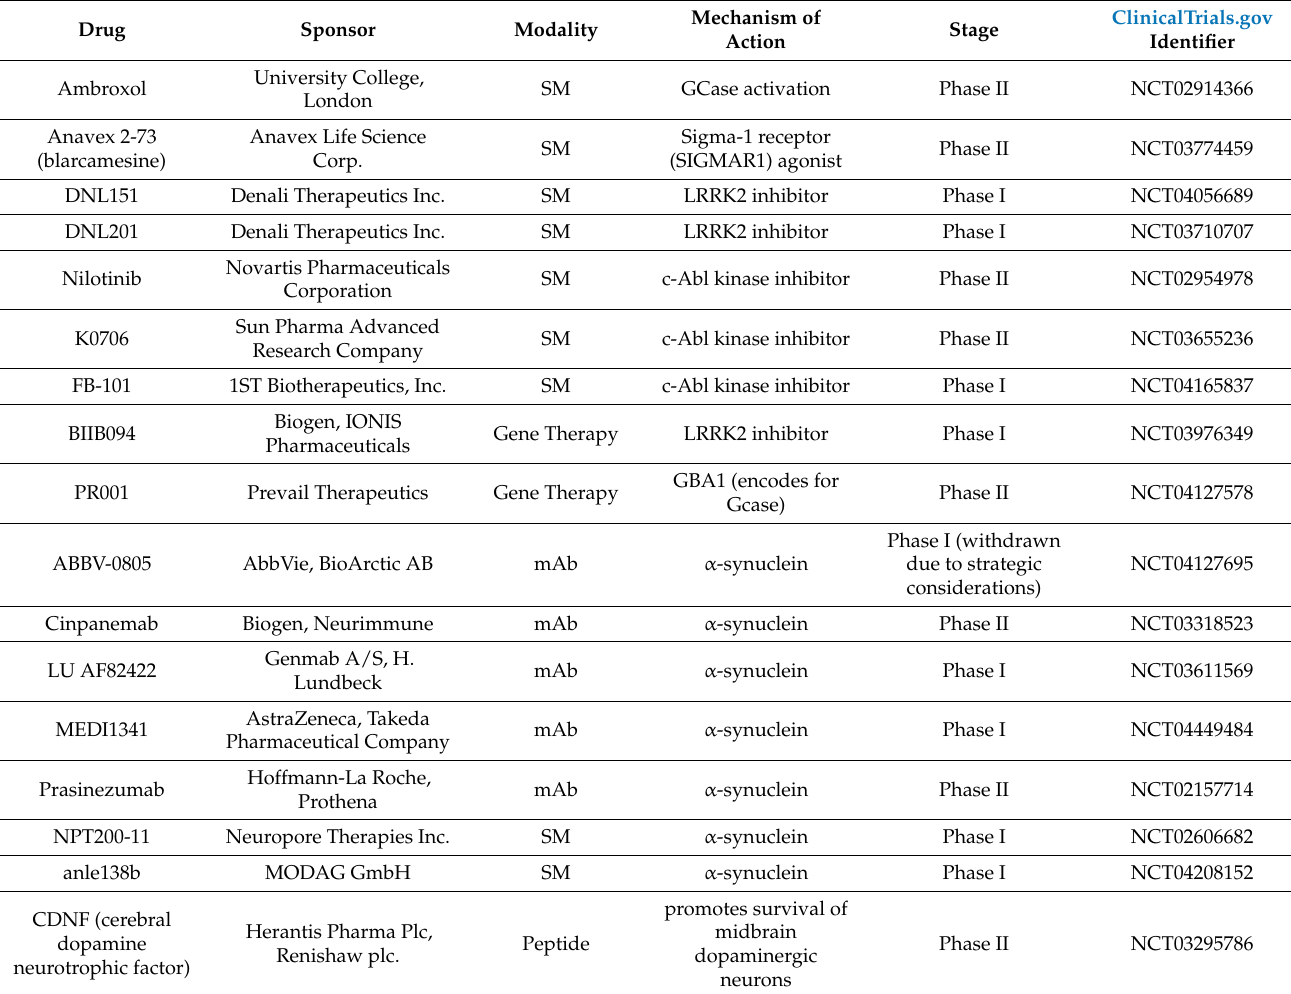
Table 15. Status of select PD DMT drugs in clinical